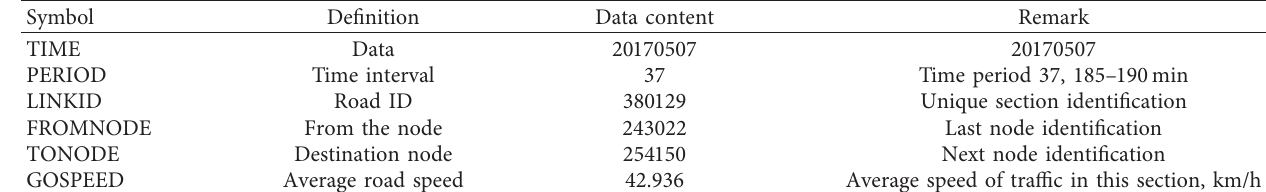
Table 1: Data format of floating